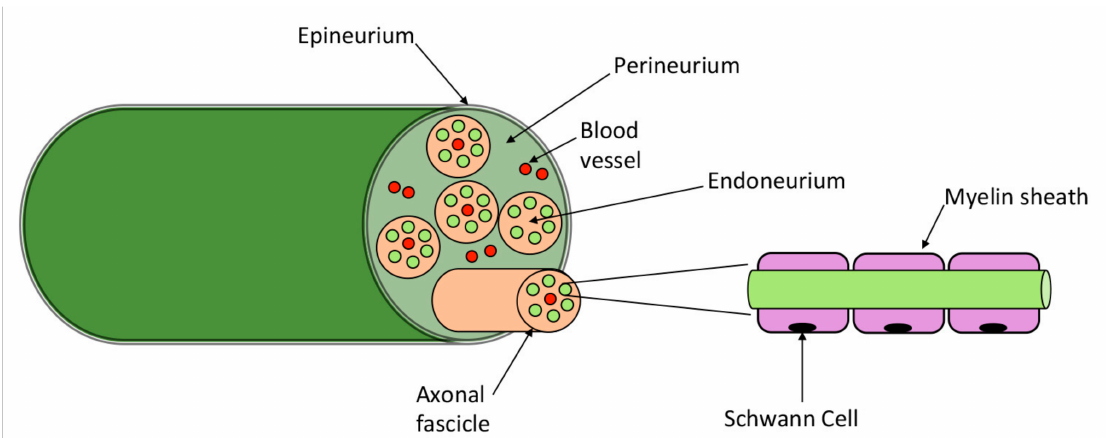
Figure 2. Peripheral nerve structure. The endoneurium is the innermost layer and consists of nerve fibers, composedofaxonssurroundedbydifferentsubtypesofSchwannCells(myelinatingandnon–myelinating Schwann cells); it also contains blood vessels, resident macrophages and fibroblasts [56]. The perineurium, which surrounds the endoneurium, is a layer of cylindrical cells tightly interconnected with tight and gap junctions, forming a protective barrier [57]. The epineurium is the outermost layer surrounding several nerve bundles; it includes an elastin and collagen sheath, blood and lymphatic vessels, resident macrophages and mast cells, fibroblasts. The epineurium is itself–innervated by small axons deriving from the endoneurium